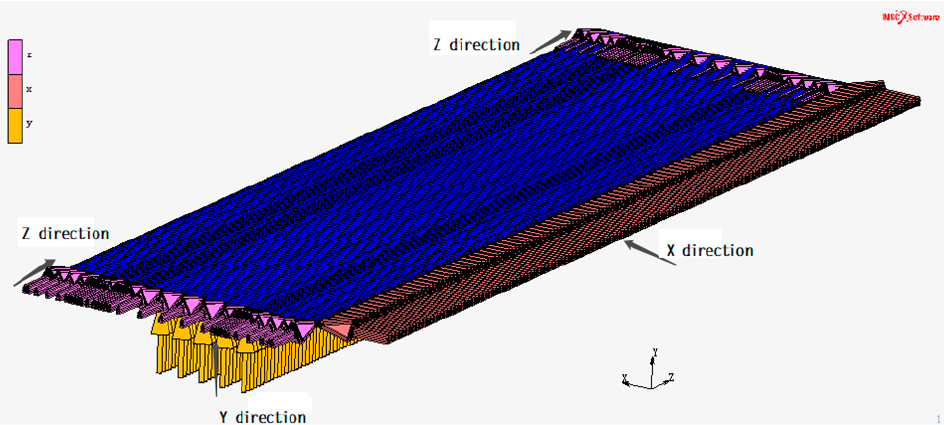
Figure 5. Setting of boundary conditions of the lower beam model.